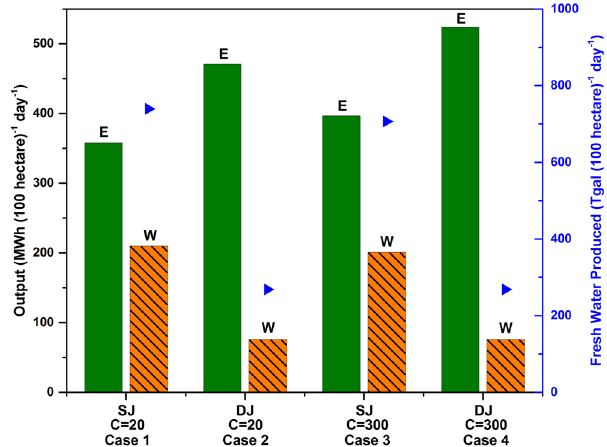
Figure 4. Electricity generated ( E ) and heat recovered ( W ) along with the fresh water produced (indicated by the arrows) from the recovered heat per 100 hectare of land for two solar concentration cases of 20 and 300. Calculations are based on an annual average direct normal irradiation of 6.65 kWh/m 2 /day.